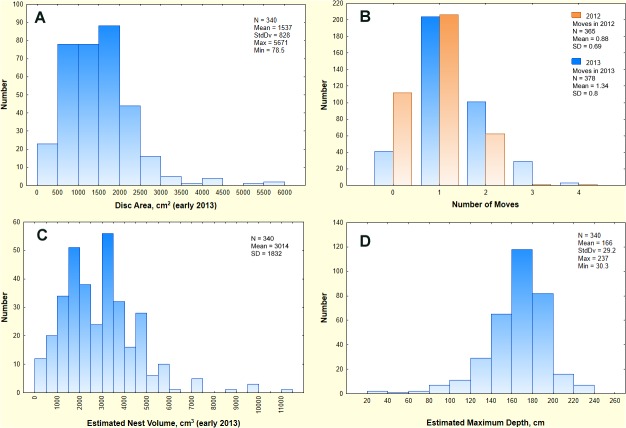
The frequency distributions of the Ant Heaven parameter values used in the simulations.A. Disc area (cm2) early in 2013 before colonies began to relocate. These areas therefore represent colonies that have been in place for at least 5 months over the winter and can be found in S5 Table. The distribution is best fit by a gamma distribution with a mean = 1537, S.D. = 828. B. Colonies of P. badius average about one move per year, with most moves taking place in June through October. During 2012–2013 a total of 840 moves were observed, with individual colonies moving from once per 2 years to 4 times per year. C. The total nest volume estimated from the surface nest disc ranged from about 100 cm3 to almost 12,000 cm3, with a mean of about 1500 cm3. D. The frequency distribution of maximum nest depth at Ant Heaven, as estimated from the relationship among nest disc area, total chamber area and maximum nest depth (Table 1).